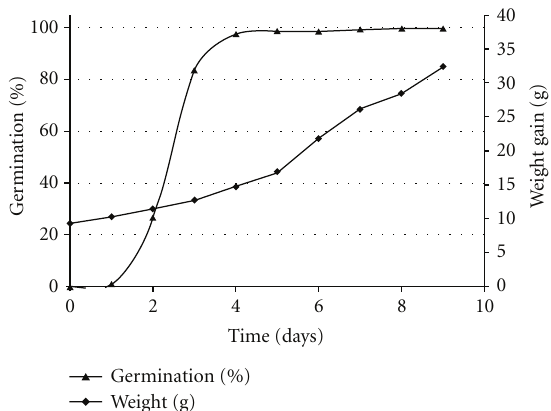
Figure 1: Germination (%) and weight gain (g) of the L. campestris seeds. The results represent the average of three independent experiments ± S.